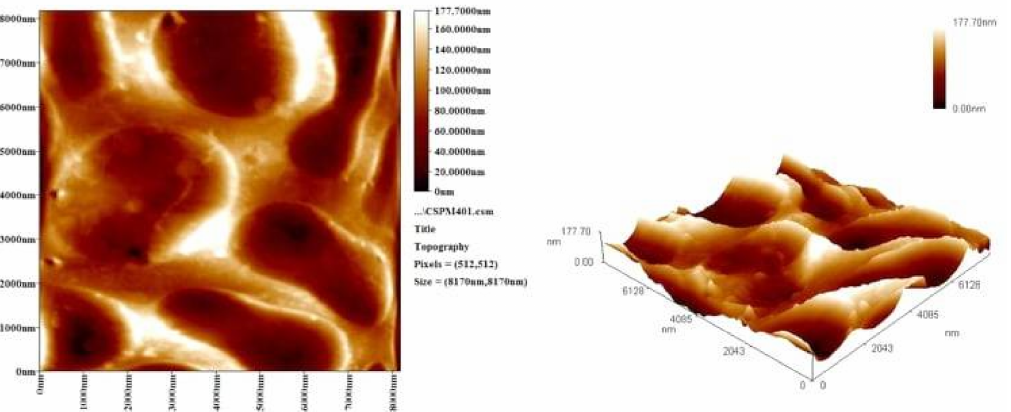
Figure 6. Atomic force microscopy (AFM) images of PVC (blank) film after 120 min of thermal degradation at 180 ◦ C.